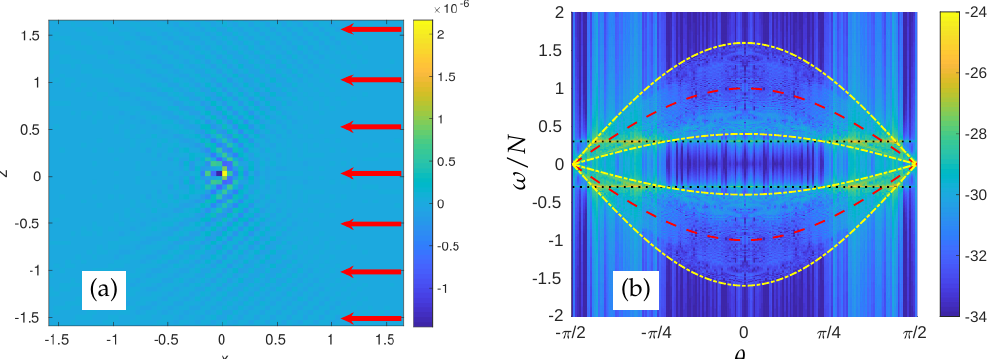
Figure 5. Sweeping effect of a homogeneous horizontal mean velocity field on the Saint Andrew’s cross pattern of propagation of internal gravity wave. ( a ) Vertical velocity u z in the ( x , z ) plane in physical space where the red arrow illustrate horizontal velocity with c x = − 10 − 2 (zoomed in). ( b ) The corresponding concentration of energy density E ( θ , ω ,56 < k ≤ 60 ) in the ( θ , ω ) Fourier domain (in log scale). Red dashed line: original dispersion relation curve ω r ( θ ) for internal gravity waves defined by Equation (2). Black dotted line: forcing frequency ω f . Yellow dash-dotted line: deviation of the dispersion relation for k = 60 defined in Equation